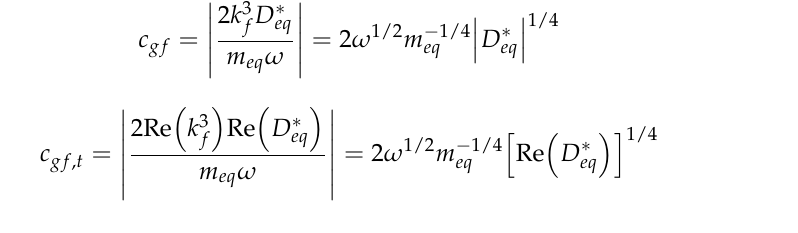
Figure 8. Energy density distribution for a plate with FFLD treatment of various thickness of damping layer ( f = 3 kHz, η 2 = 0.8).